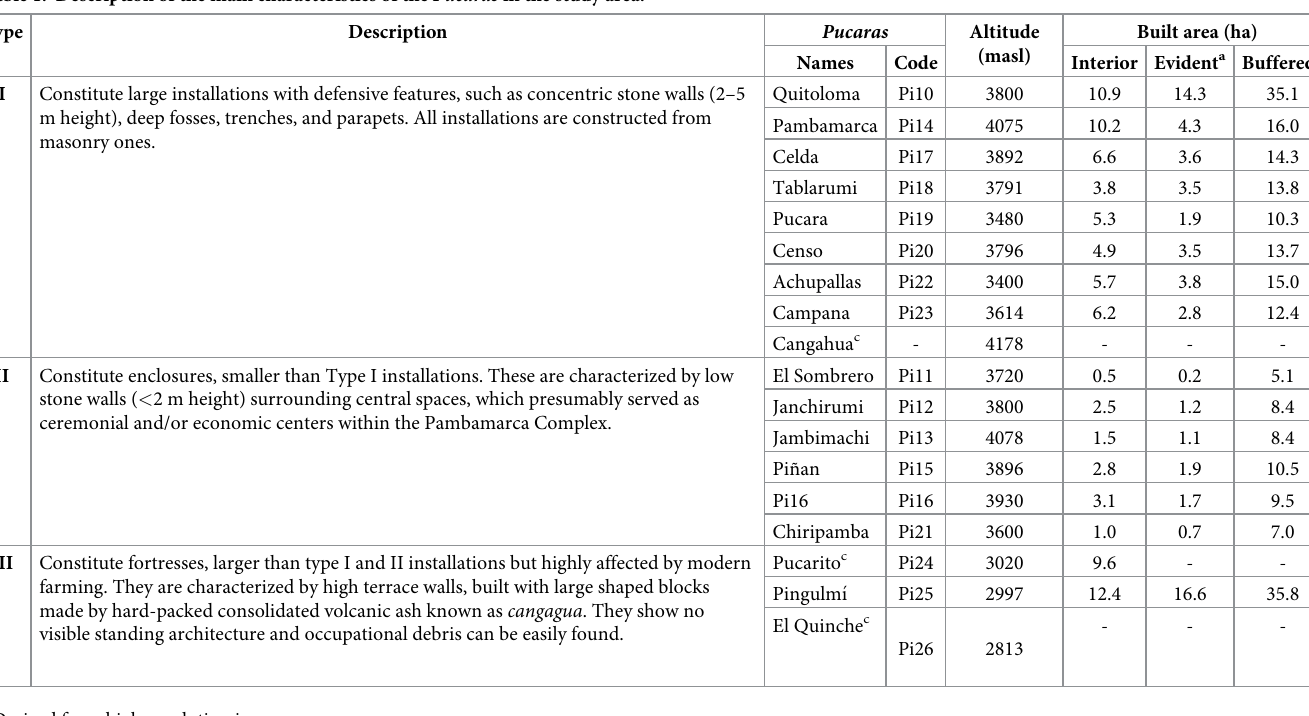
Table 1. Description of the main characteristics of the Pucaras in the study area.